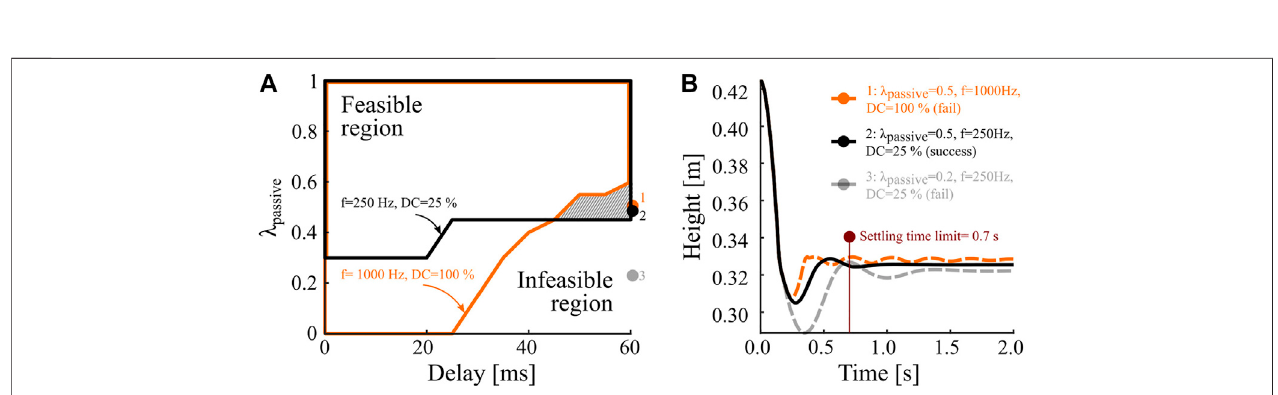
FIGURE 7 | For simulations with a 25% duty cycle and 60 ms feedback delay feasible solutions are visible for compliance ratios of λ (cid:1) 0 . 5 (B , solid black). In the indicated overlapping parameter area (A) , the 100% duty cycle simulation fails with insuf fi cient settling time (B , dashed orange).